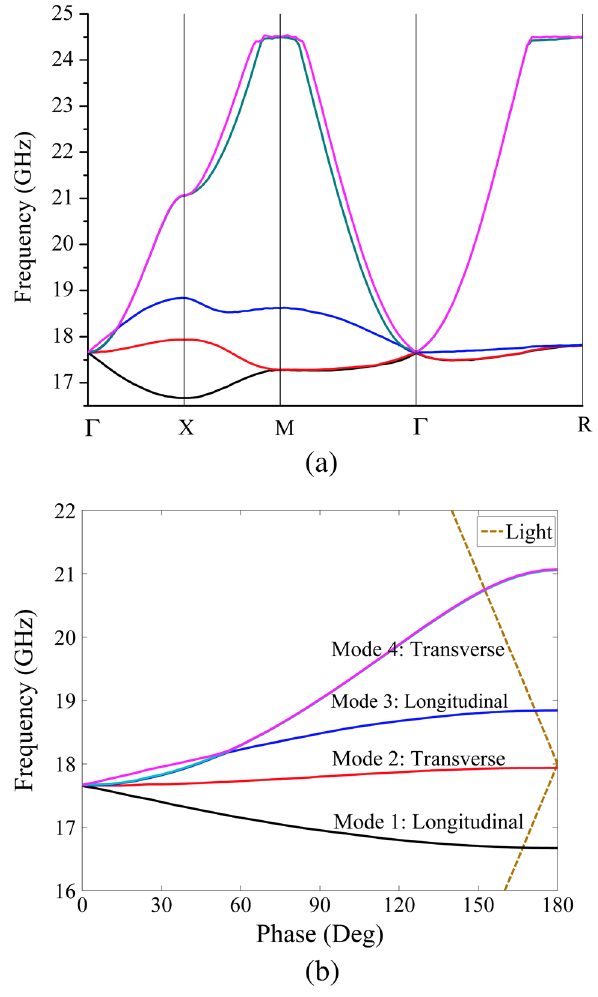
FIG. 2. Brillouin diagram of a unit cell. (a) Different regions in the first Brillouin zone. (b) Γ − X region dispersion showing the intersection with the light